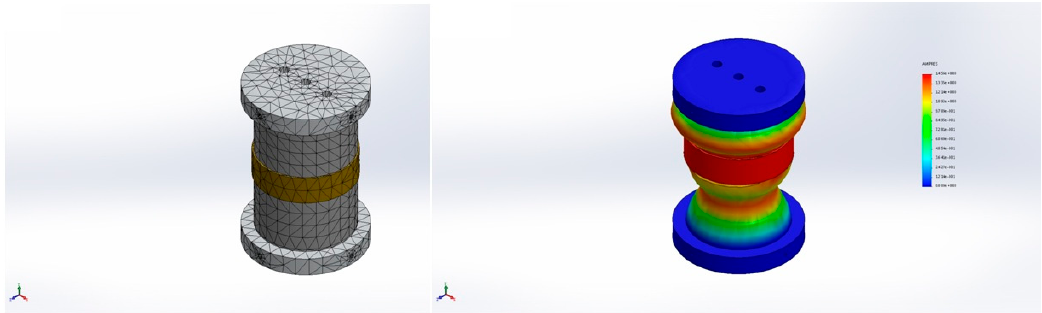
Figure 7. The mesh and the result for FEM simulation.